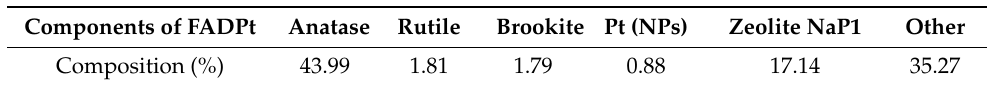
Table 1. The composition of the FADPt.